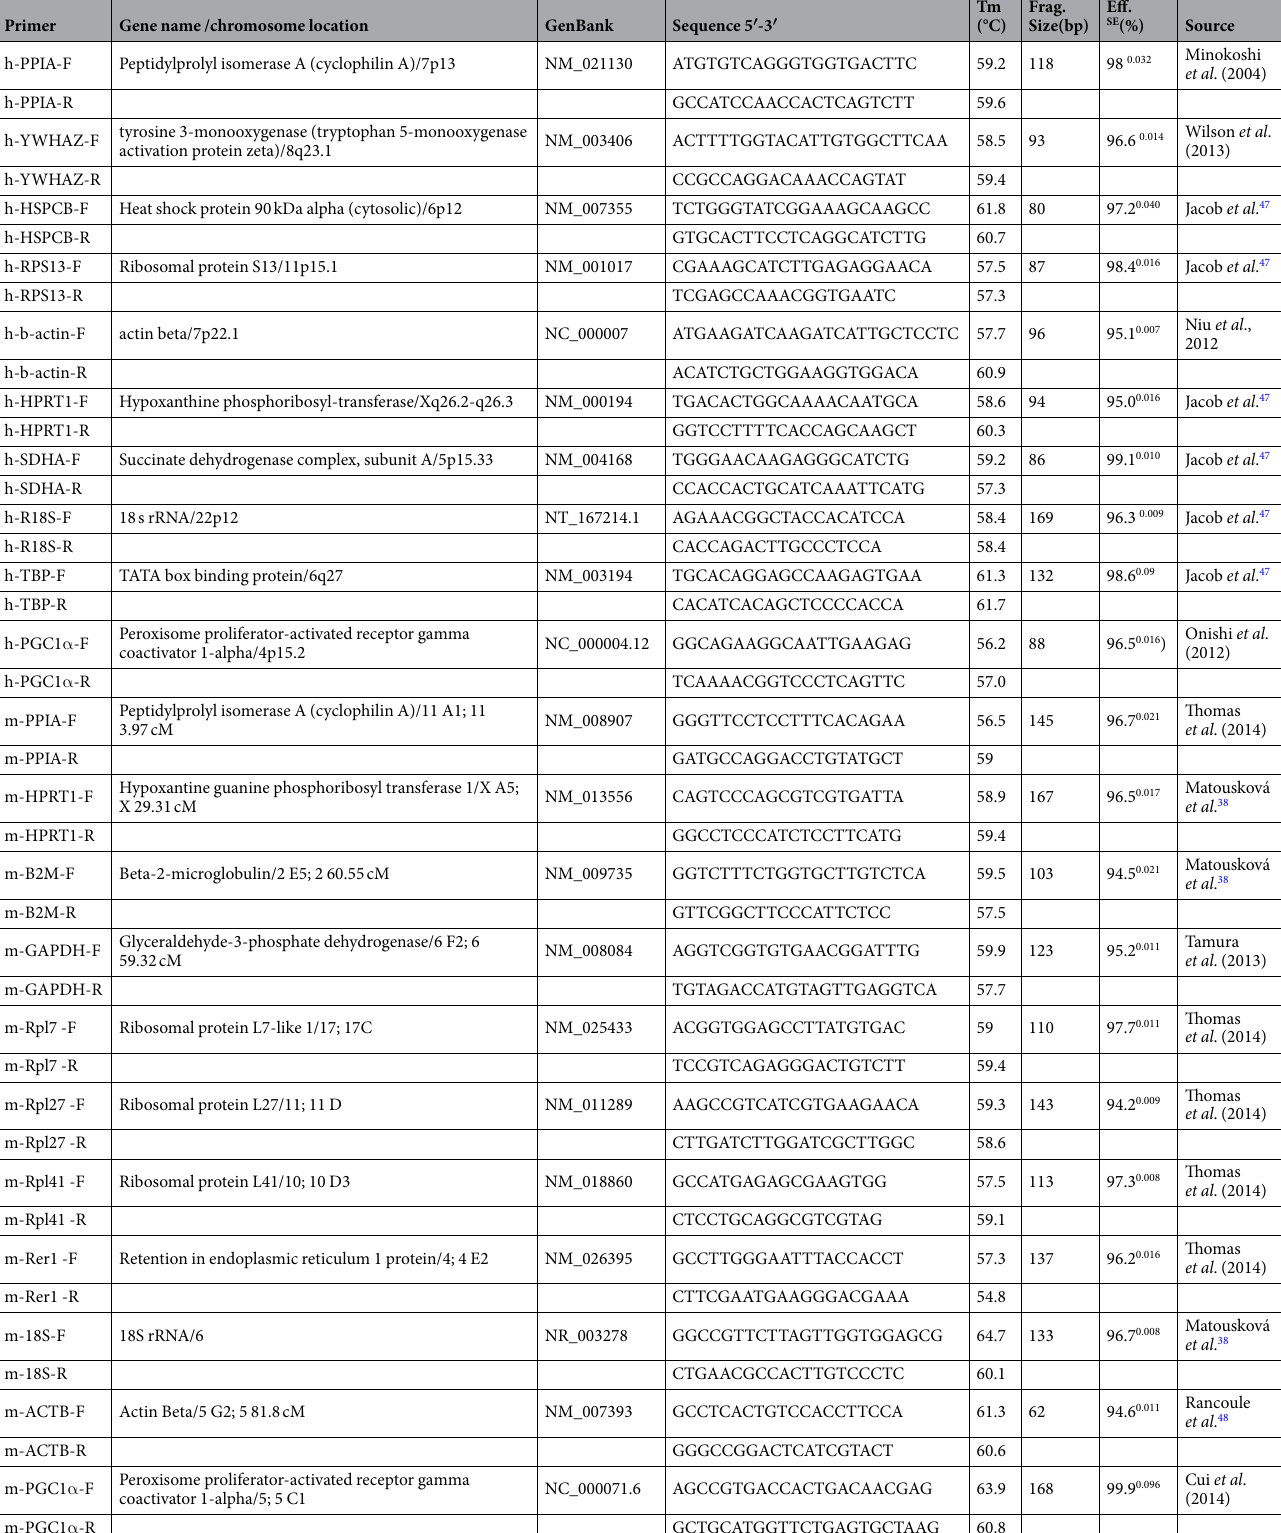
Table 1. Details of specific primers and targets used in real-time qPCR